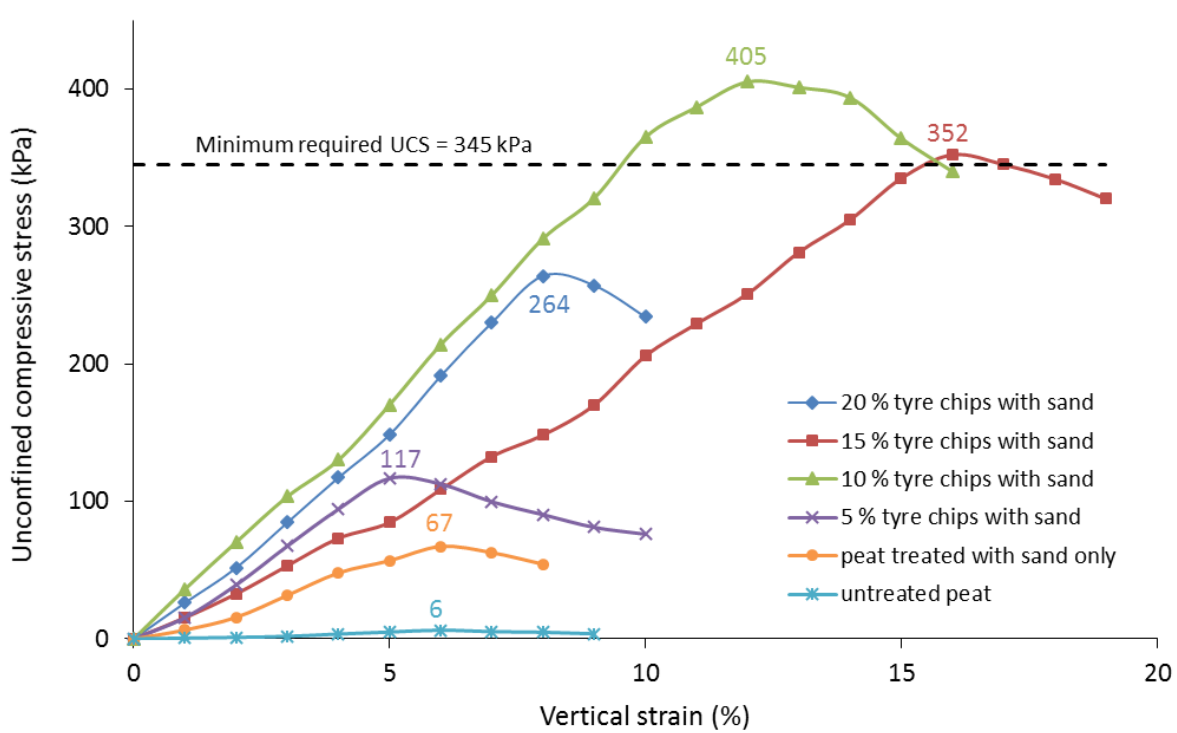
Figure 4. Results of unconfined compression testing for different soil specimens. In each case, unconfined compressive strength (UCS) is equal to stress (the label value) at the peak of the stress-strain curve.